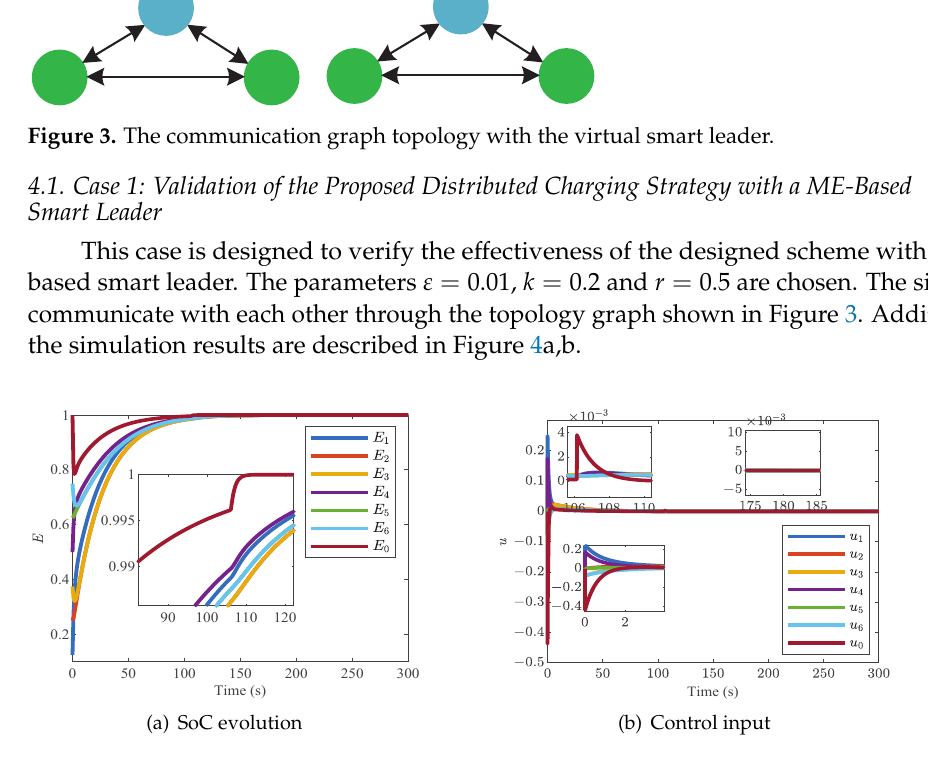
Figure 4. SoC evolution and control input of the system under the distributed charging strategy with a ME-based smart leader in Case